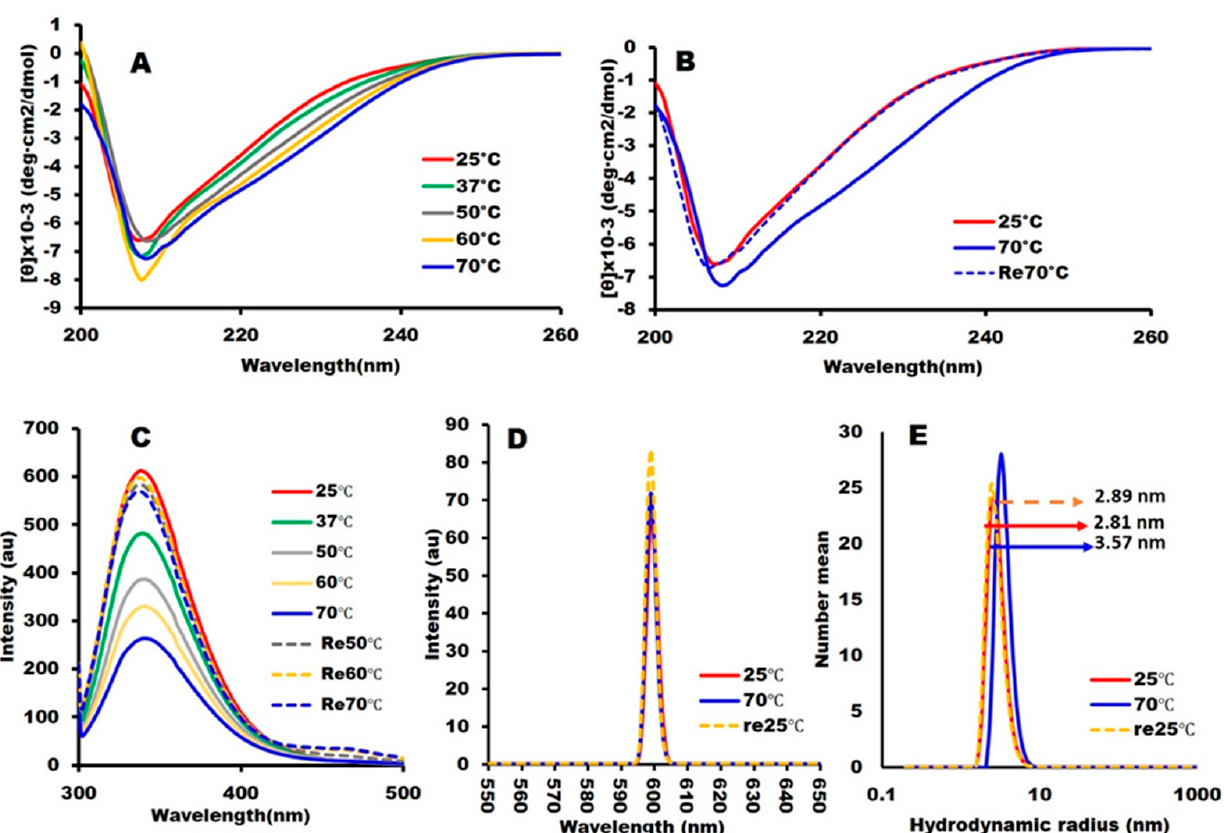
Figure 2. Biophysical and spectroscopic characterization: All spectroscopic measurements were performed at a protein concentration of 0.3 mg/mL in 10 mM Hepes buffer, pH 6.5. Characterization of the secondary structures: ( A ) The secondary structures were analyzed using the far-UV CD region (200–260 nm) and ( B ) The reversibility of the CD spectra at 70 ◦ C to 25 ◦ C for SARS-CoV-2-RBD. ( C ) Characterization of the tertiary structures: Tryptophan fluorescence intensity ( D ) SARS-CoV-2 RBD particle sizes are measured by dynamic light scattering (DLS) and ( E ) static light scattering (SLS). Line symbols are explained within the panels. The binding to the ACE2 (angiotensin-converting enzyme) receptor is a critical step for SARS-CoV-2 to enter target cells [12]. The integrity of the E. coli -produced RBD was thus tested by its binding to hACE2 (human ACE2). RBD/hACE2 had a binding affinity of 7.95 × 10 − 9 M (Figure 3), indicating that the E. coli -produced RBD recognizes the binding site on ACE2, further confirming its native-like